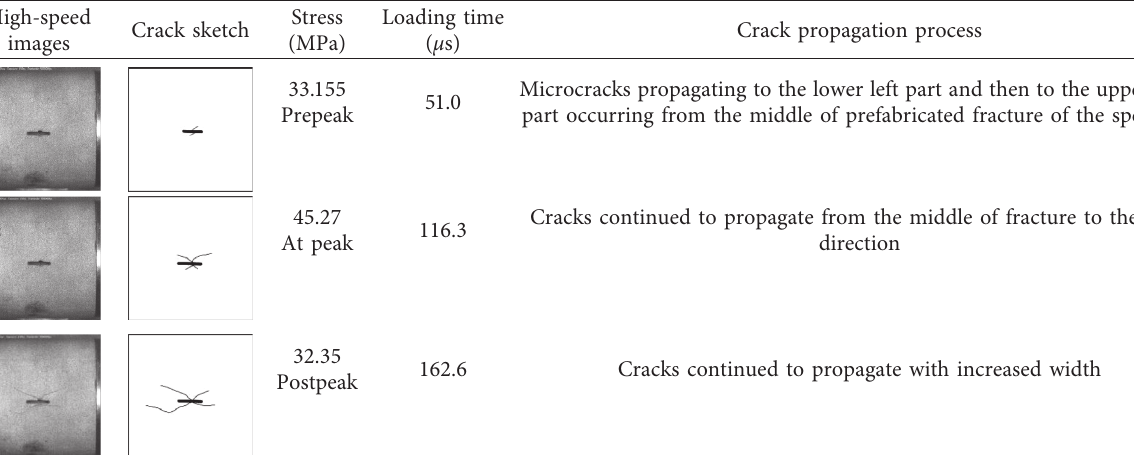
Table 6: Crack propagation process of Specimen b2 at the loading rate of 10.6m/s.